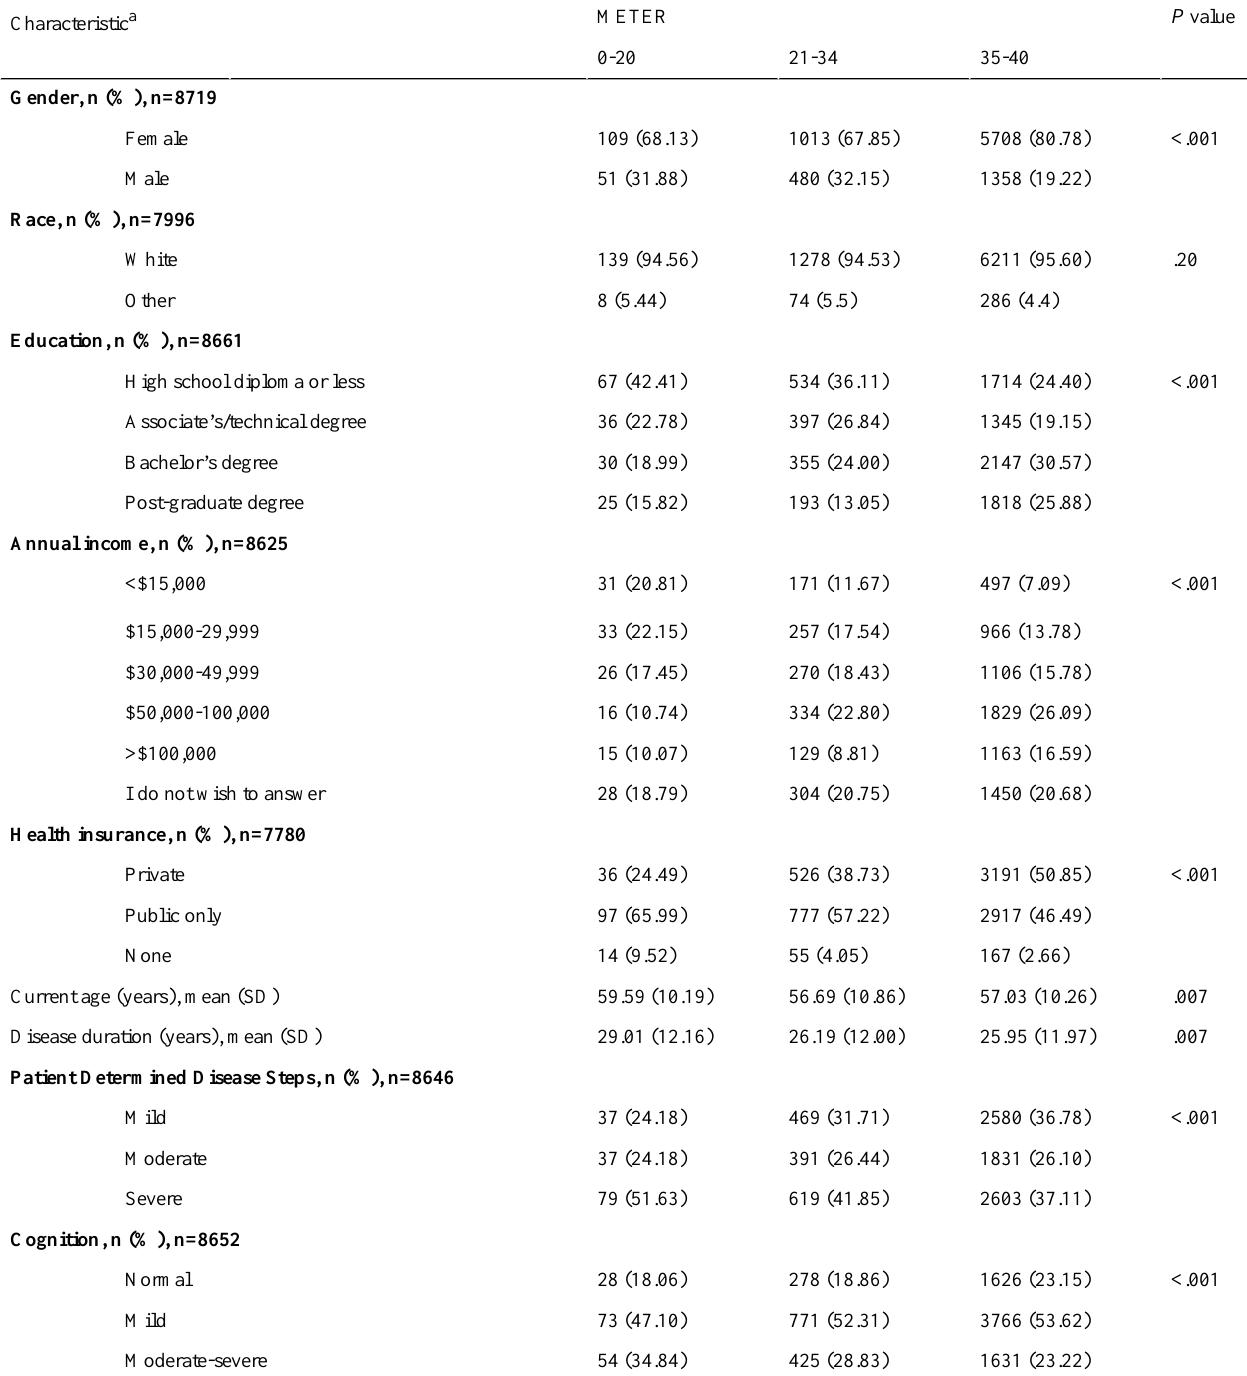
Table 2. Univariate associations between participant characteristics and health literacy as measured by the Medical Term Recognition Test (METER).